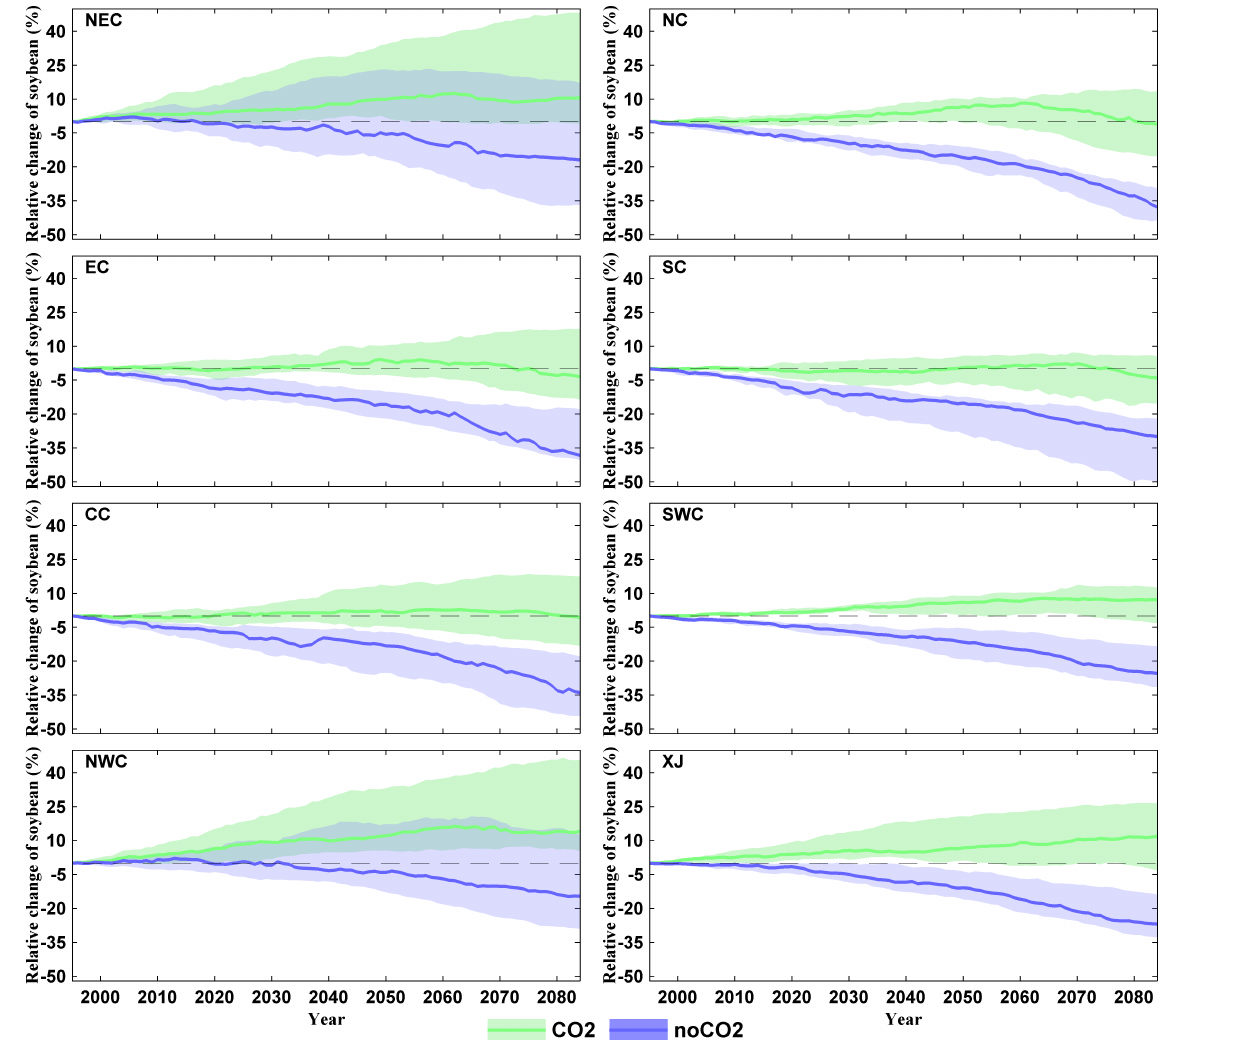
Figure 6. The relative change in the simulated soybean yield in the eight regions with and without the CO 2 effect. The MMs and the 25th and 75th percentiles of the model pairs are